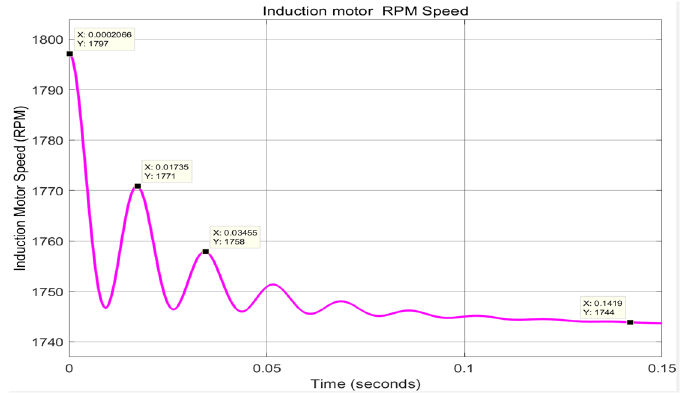
Figure 29. The MATLAB simulation result of unregulated RPM speed of induction motor.